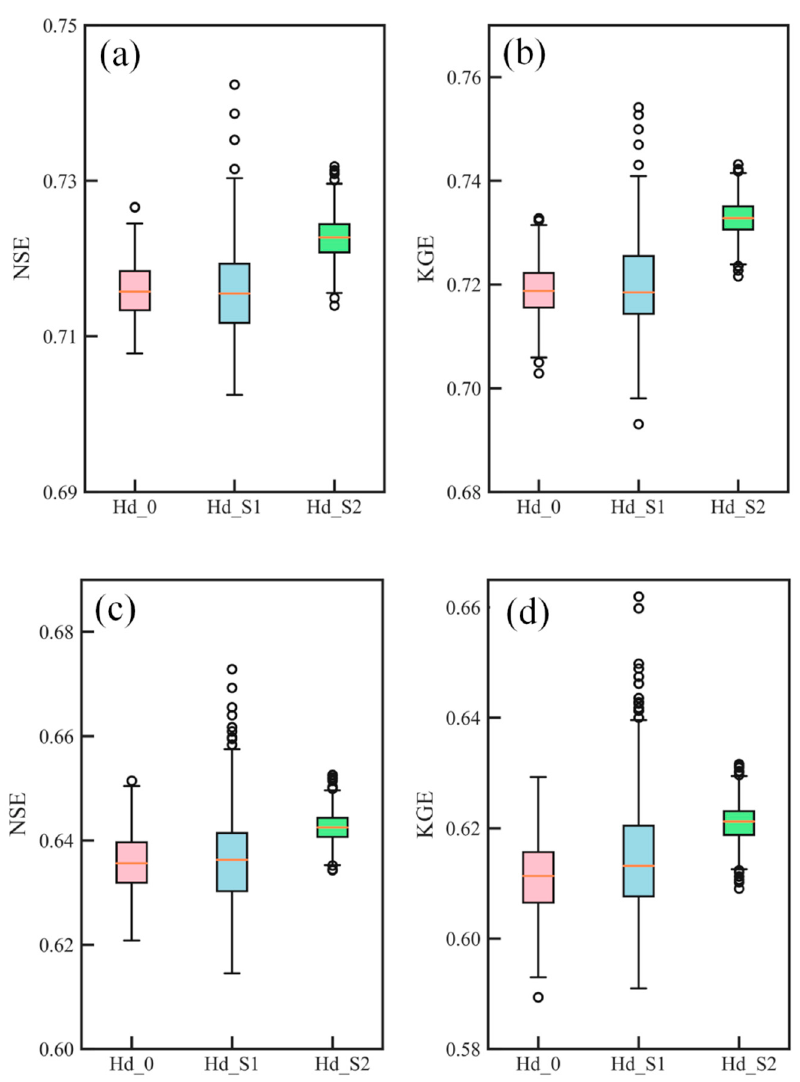
Figure 9. Performance for Xiangtan station ( a , b ) and Hengyang station ( c , d ) at the Xiangjiang River catchment in terms of NSE and KGE using parameter sets from the donor catchment. The boxplots represent the variation due to 2000 simulations.